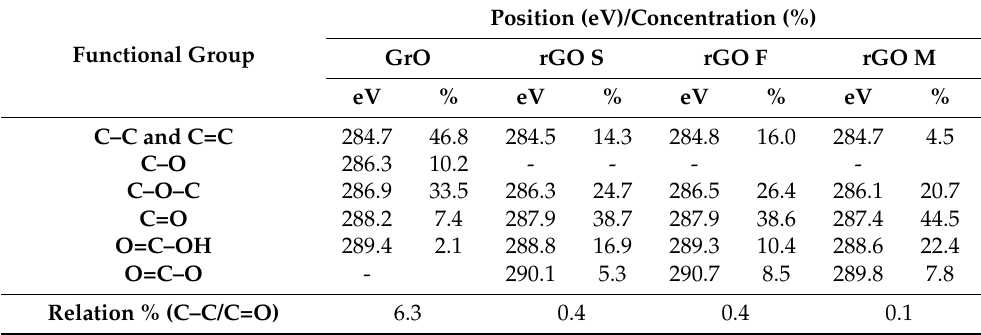
Figure 1. Fourier-transform infrared spectroscopy (FTIR) of graphite (GrO) and GO nanohybrids with starch (GO S), fructose (GO F), and micro-cellulose (GO M). Table 1. Functional groups and percentages obtained by X-ray photoelectron spectra (XPS) of graphite (GrO) and nanohybrids rGO S, rGO F, and rGO